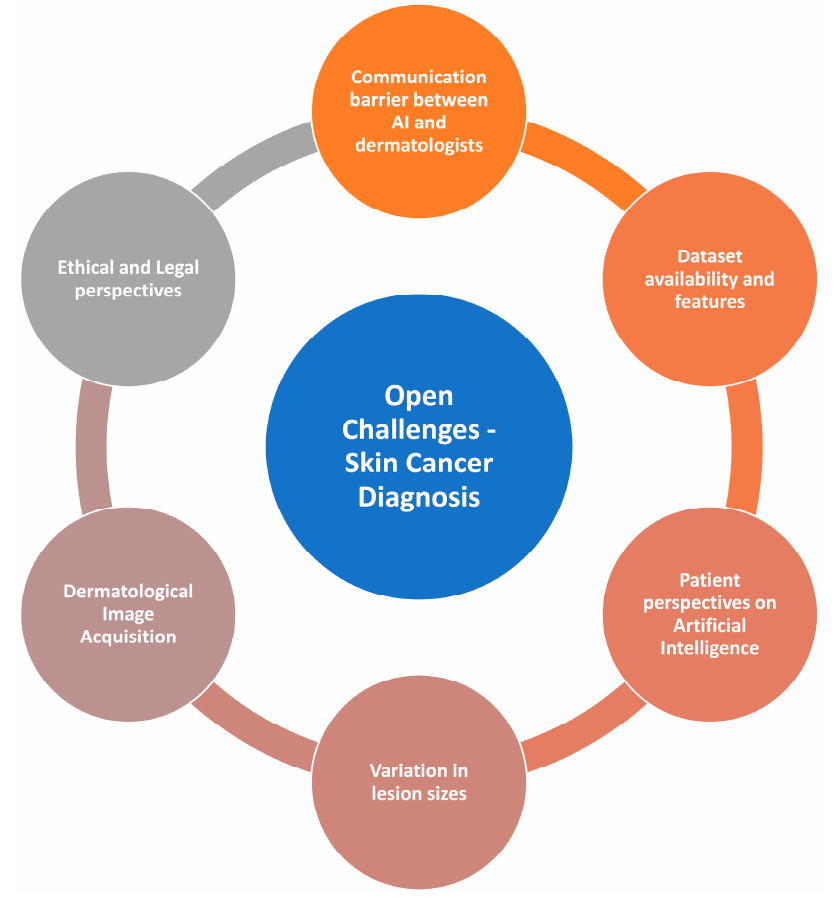
Figure 9. Open challenges in skin cancer diagnosis.